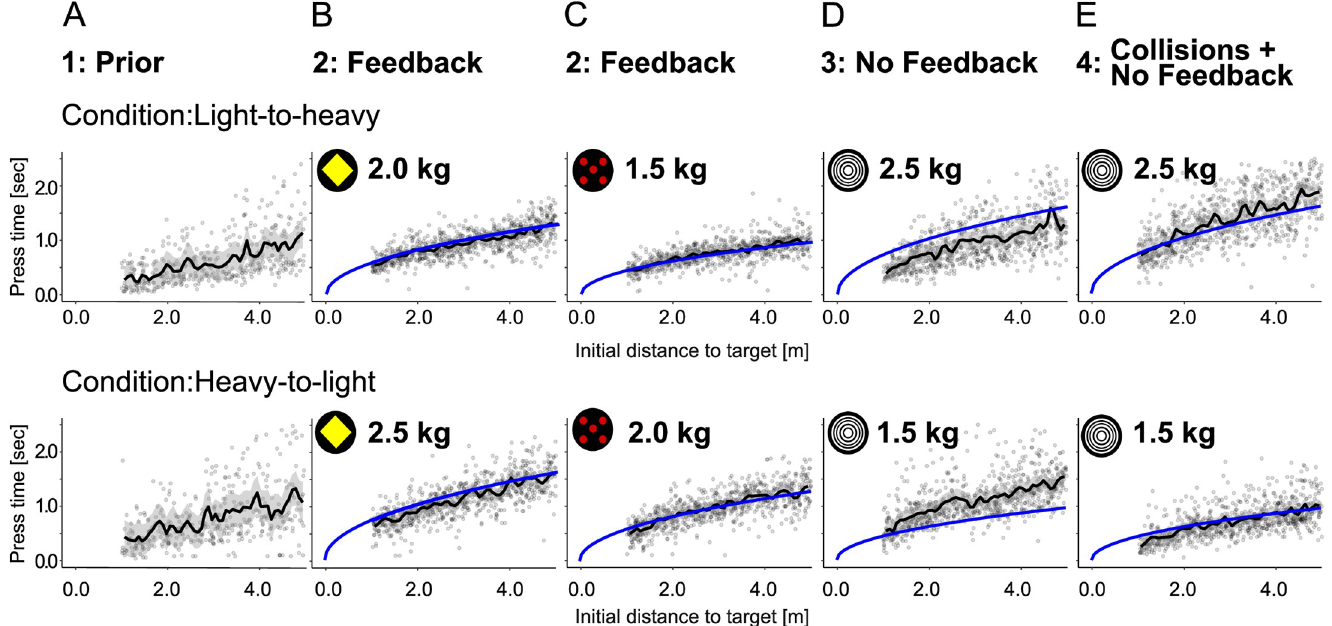
Fig 2. Press-times as function of initial distance to target. Press-times for all participants by condition and experimental phase are shown with data points in black and Newtonian relationship with perfect knowledge about the involved parameters in blue. The top row shows the data of subjects in the light-to-heavy condition and the bottom row shows the data of subjects in the heavy-to-light condition. (A) Press-times of participants in the first phase (“prior”), (B) second phase (“feedback”) for the yellow puck, (C) second phase (“feedback”) for the red puck, (D) third phase (“no feedback”), and (E) last phase (”collisions and no feedback”) after having seen 24